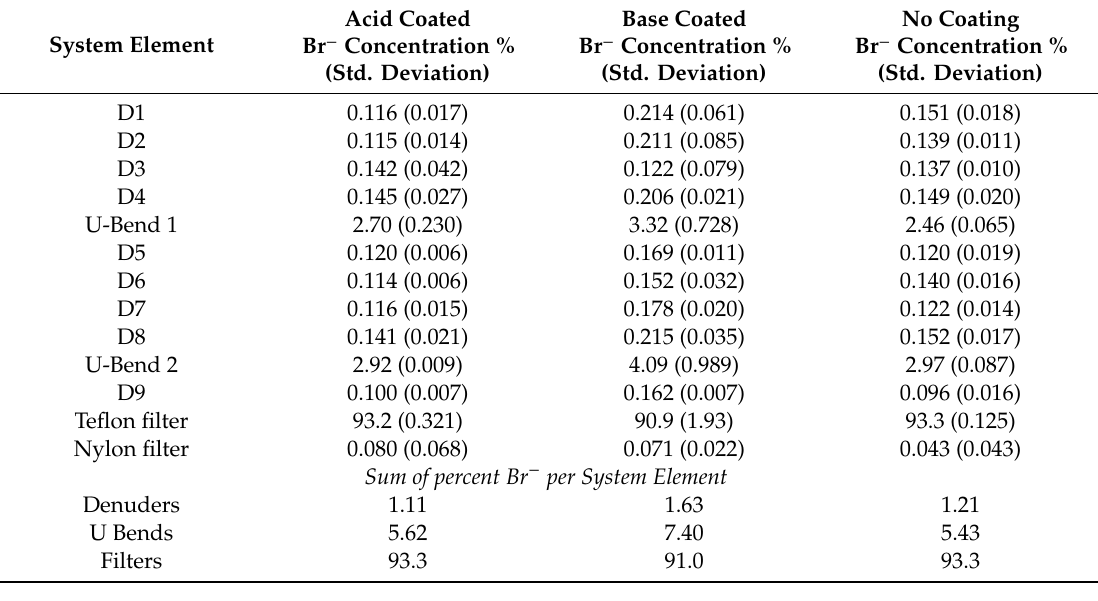
Table 6. Average KBr (as Br − ) concentration percentage of the 9-ADS set-up. The values are given as the average percentage of the three trials conducted per coating treatment type (acid, base, or no coating) for a total of nine trials. The standard deviation is presented in brackets for each of the three coating types.